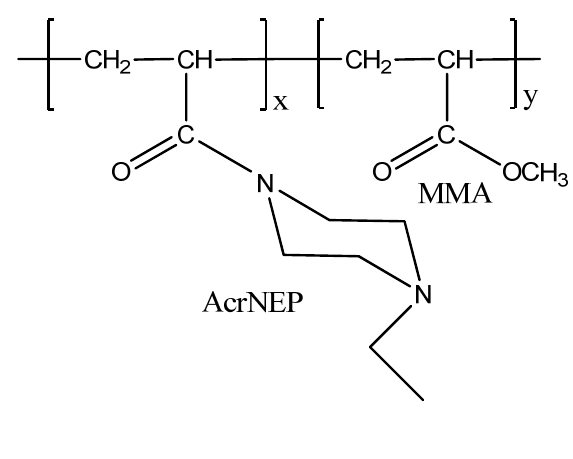
Figure 1. Chemical structure of the